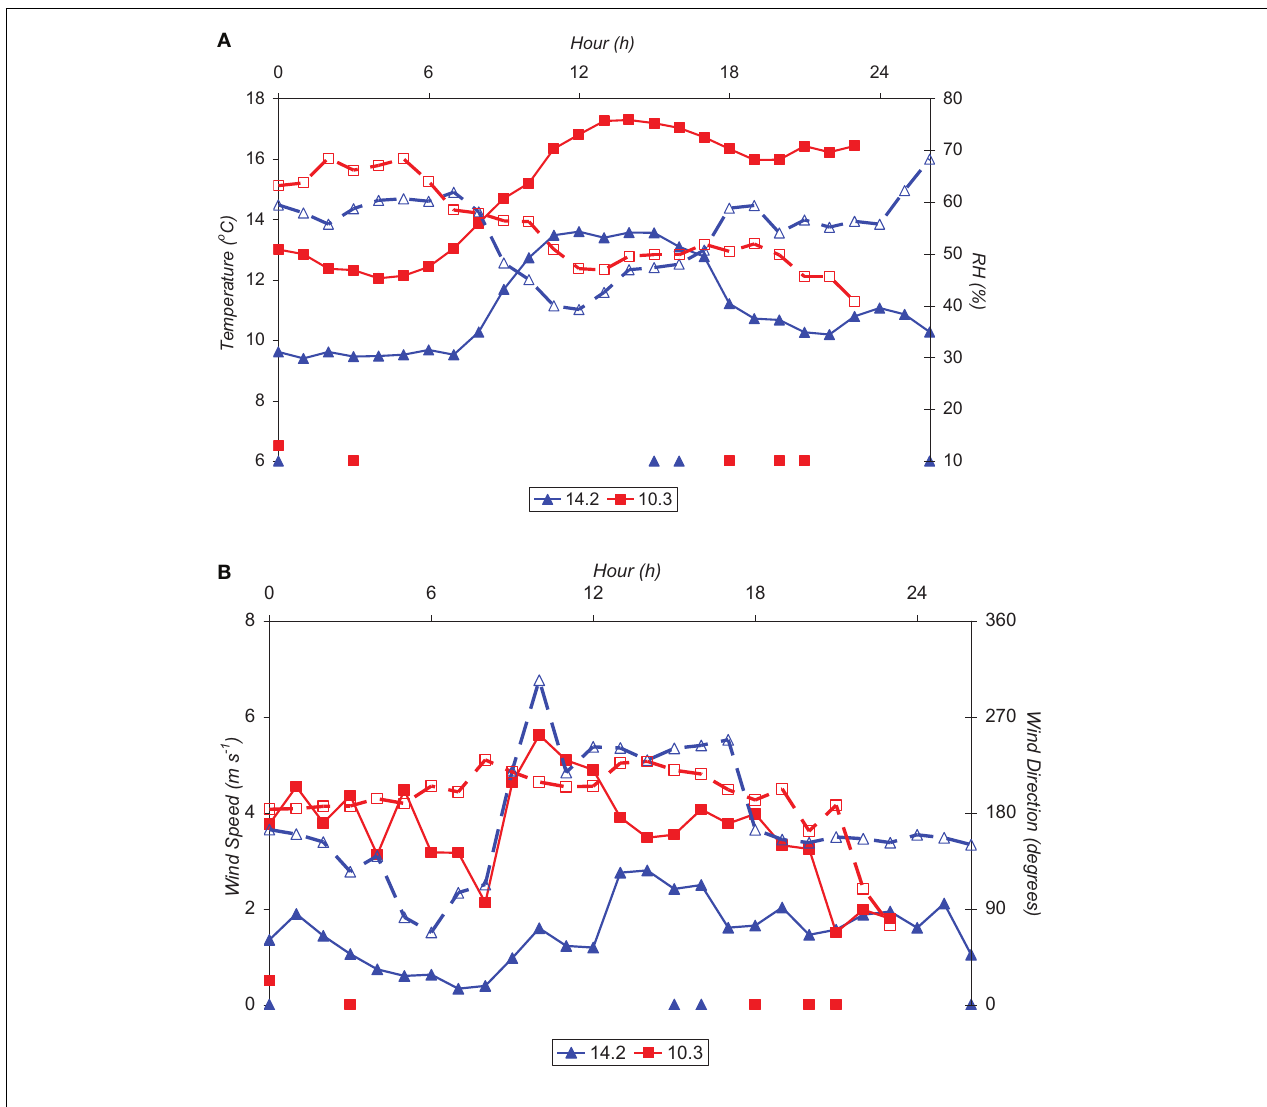
FIGURE 4 | Time series of (A) mean hourly temperature (continuous lines with closed symbols) and relative humidity (dashed lines with open symbols) and (B) wind speed (continuous lines with closed symbols) and wind direction (dashed lines with open symbols) for the